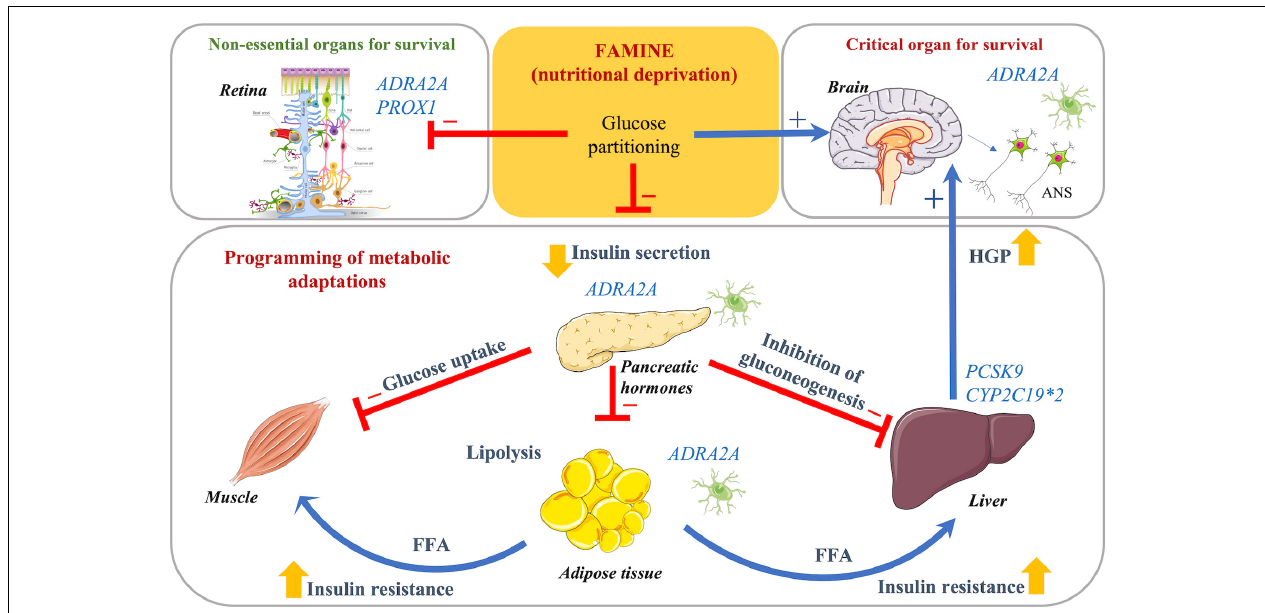
FIGURE 4 | Schematic representation of the suggested mechanisms underlying association between perinatal famine exposure and the risk of proliferative retinopathy in adults with type 2 diabetes. An exposure to starvation induces a situation of nutritional deficits confronting the body to maintain metabolic balance by shunting the energy, i.e., glucose being the main source, from non-essential peripheral organs (including retina) to critical for survival organs (brain). Insulin secretion from the pancreas is reduced to slow down uptake of glucose in the periphery (muscle, liver, and adipose tissue), while endogenous hepatic glucose production (liver) is increased to partition and supply glucose to the brain. In addition to the adaptive insulin resistance, lipolysis is induced to release free fatty acids as backup system to be used as energy sources by non-essential organs and tissues; ADRA2A is abandonedly expressed in the neuronal tissues surrounding pancreatic islets, adipocytes, hepatocytes, and neuroretinal glial cells. This supports the concept of the metabolic re-programming of insulin secretion and action as well elevated lipolysis during early life as an adaptive mechanism to nutritional deprivation. The nerves may mediate these programming effects of increased predisposition to the risk of proliferative retinopathy in